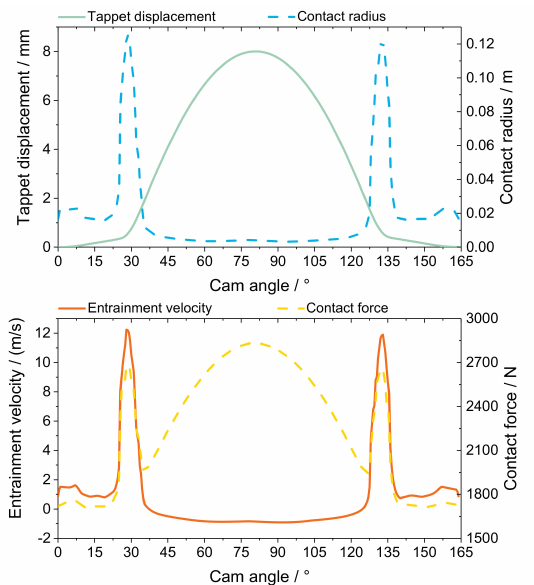
Figure 2. The kinematics and dynamics variations in a cam cycle for the tappet displacement, the contact radius, the entrainment velocity, and the contact